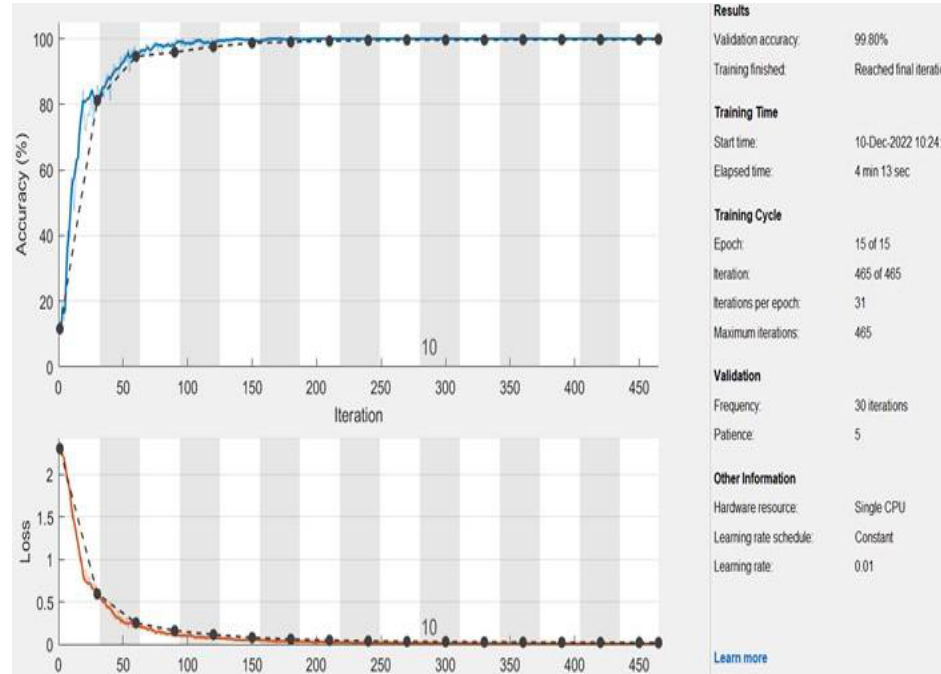
Figure 11. The achieved accuracy and loss function charts.